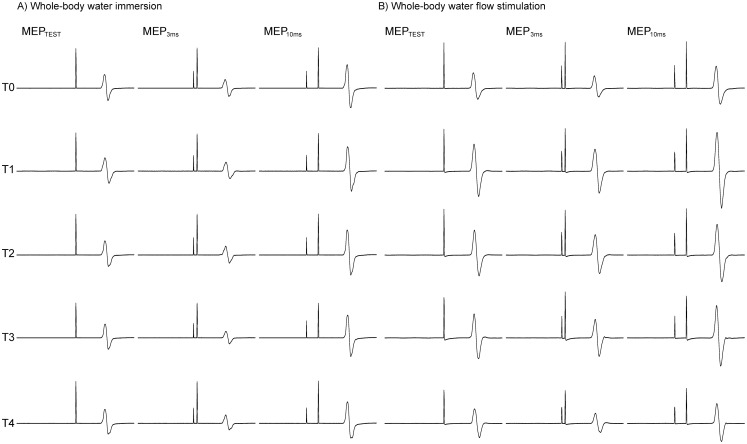
Raw data traces from a representative subject for each intervention.Averaged MEPs for the test stimulus (TS) alone, after conditioning stimulus (CS) by TMS at ISIs of 3 and 10 ms in (A) whole-body WI and (B) whole-body WF.